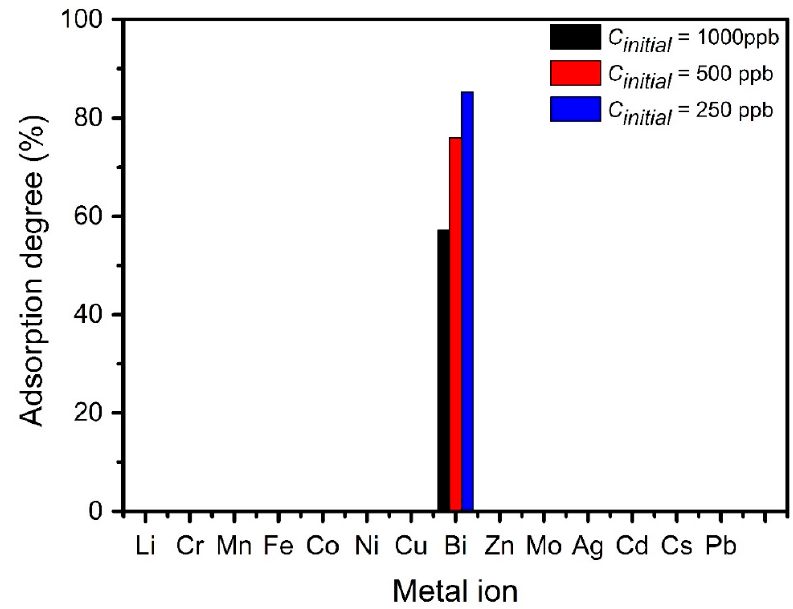
Figure 4. Adsorption from multi-element competitive aqueous solution showing exclusive adsorption of Bi 3+ with zero uptake of other competing cations.